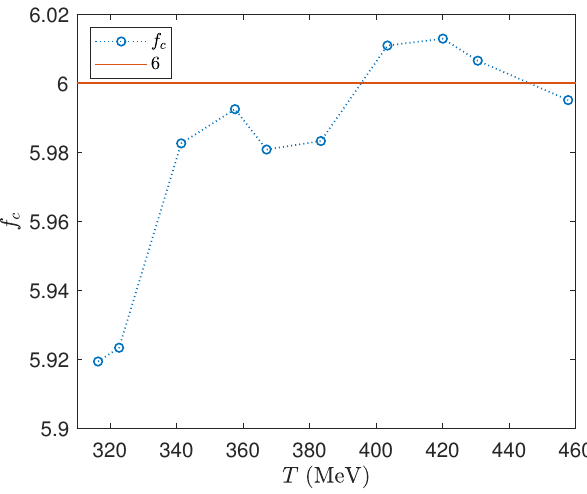
Figure 9 . f c as a function of temperature T